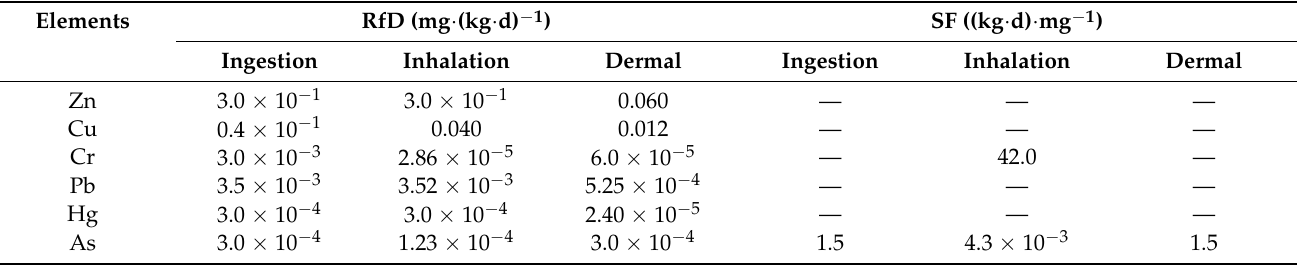
Table 2. Reference doses for non-carcinogenic metals and slope factors for carcinogenic